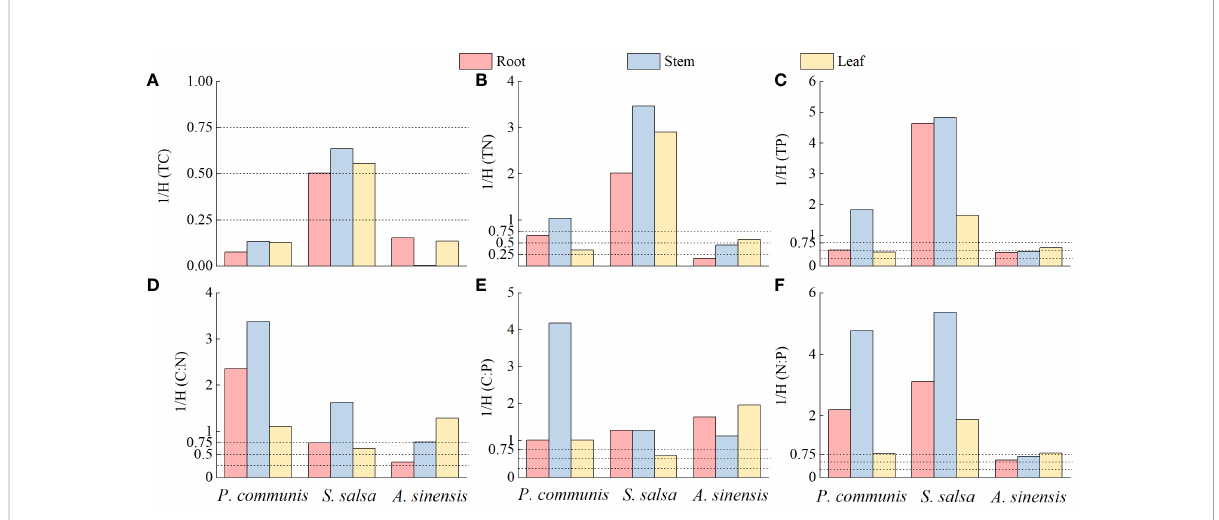
FIGURE 9 Ecological stoichiometric homeostasis indices of TC (A) , TN (B) , TP (C) , C:N (D) , C:P (E) and N:P (F) in three